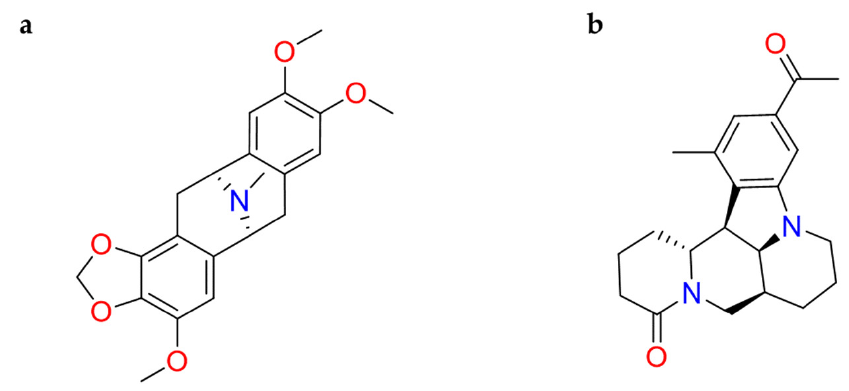
Figure 11. 2D structures of ( a ) thalimonine and ( b ) sophaline.